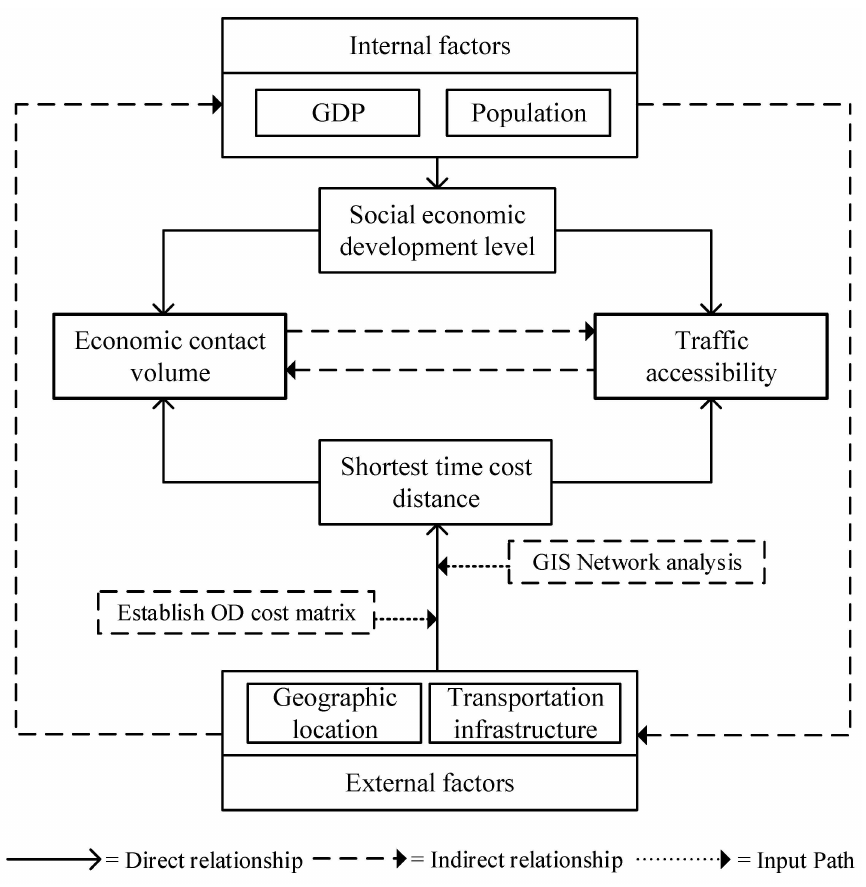
Figure 3. Framework of